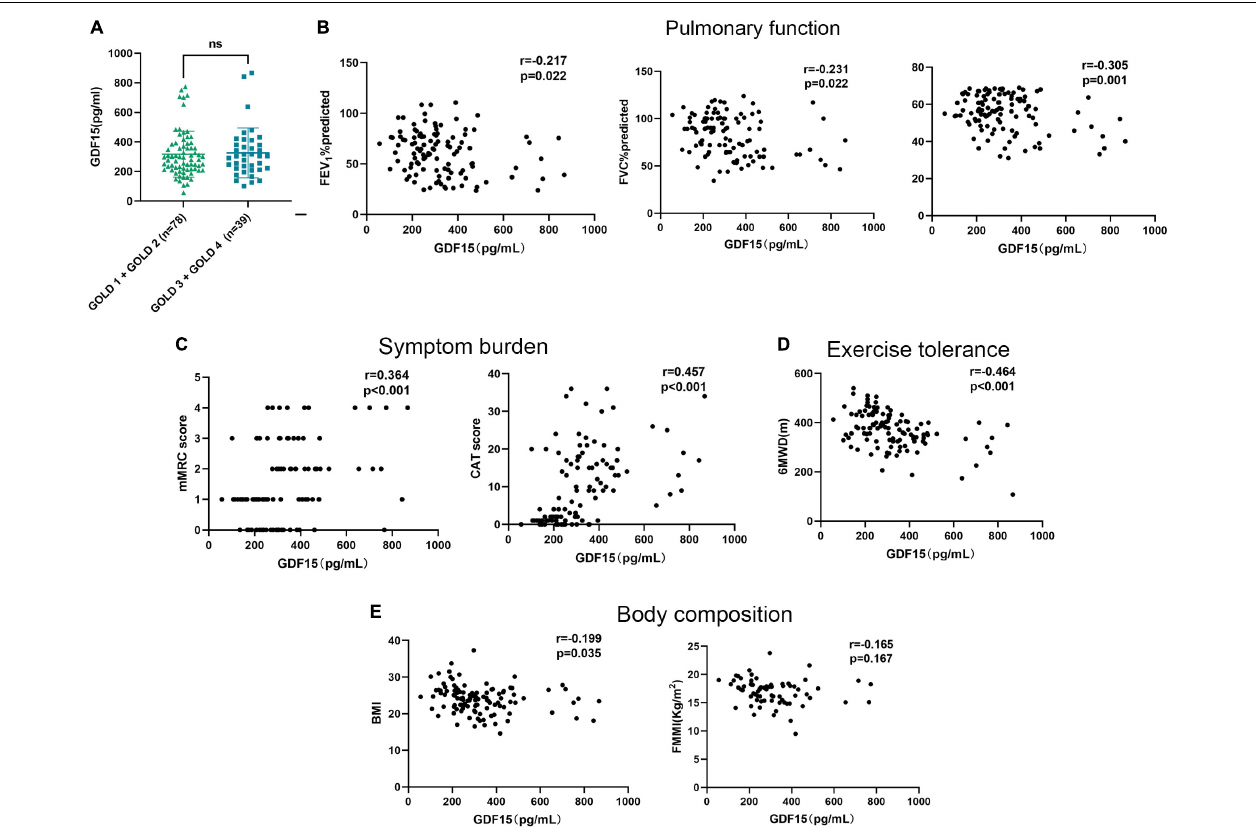
FIGURE 1 | The relationships of serum GDF15 levels with the clinical features of patients with COPD. (A) Difference in serum GDF15 level in patients with GOLD A and GOLD B and in patients with GOLD C and GOLD D; (B) the relationship between serum GDF15 level and FEV 1 %predicted, FVC % predicted, FEV 1 /FVC ( n = 117); (C) the relationship between serum GDF15 level and mMRC score, CAT score ( n = 117); (D) the relationship between serum GDF15 level and 6MWD; (E) the relationship between serum GDF15 level and BMI, FFMI ( n = 117). GOLD, global initiative for chronic obstructive lung disease; FEV 1 %predicted, forced expiratory volume in the first second percentage predicted; FVC% predicted, forced vital capacity percentage predicted; mMRC, the modified British Medical Research Council; CAT, COPD assessment test; 6MWD, 6-min walking distance; BMI, body mass index; FFMI, fat-free mass index.